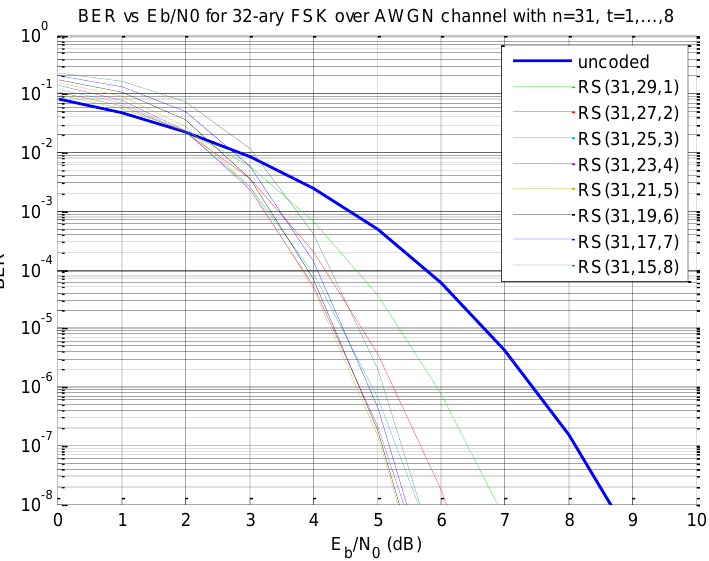
Figure 5. RS error performance for MFSK over AWGN channel with constant n and increasing t